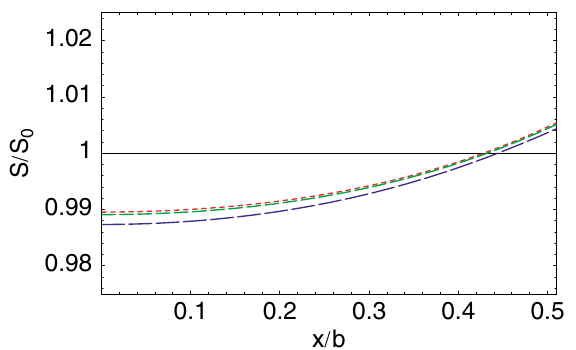
FIG. 5. (Color) Relative magnitude of beam-size corrections in a circular chamber with (cid:7) vertical beam offsets y=b (cid:3) 0 ; 1 = 4 ; 1 = 2 (short-dashed, dashed, long-dashed lines). Here 1 corresponds to a pencil beam case, i.e., to one of the three curves in Fig. 2 for the corresponding beam vertical offset.